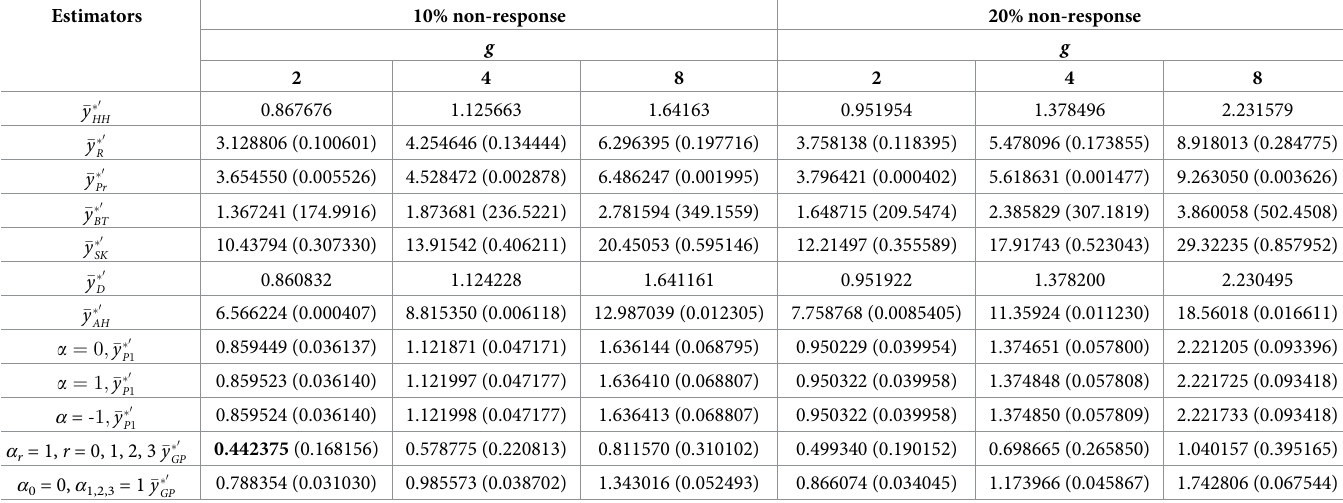
Table 11. Mean squared error and | Bias | (in brackets) values for different estimators for Population V with measurement error. Estimators